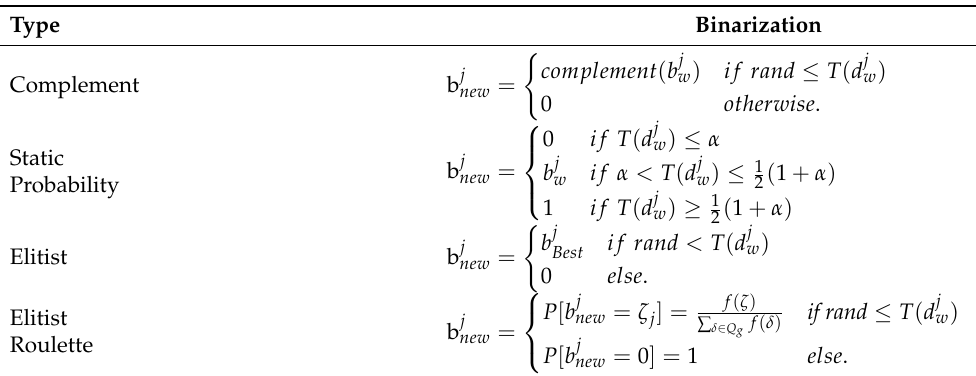
Table 9. Binarization